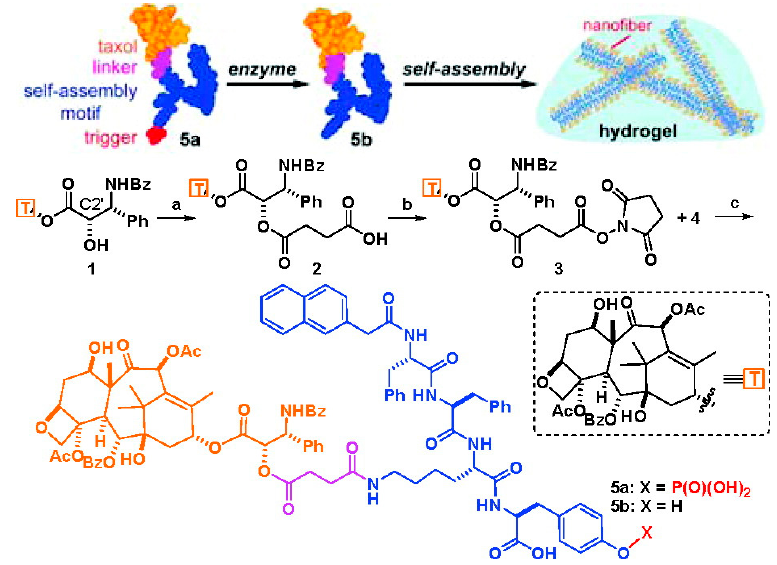
Figure 2. The schematic diagram of the formation of the first paclitaxel-derivative-based supramolecular nanofiber hydrogel obtained by the use of short peptides, and the preparation process of this paclitaxel derivative. Reprinted with permission from Copyright (2009) American Chemical Society.